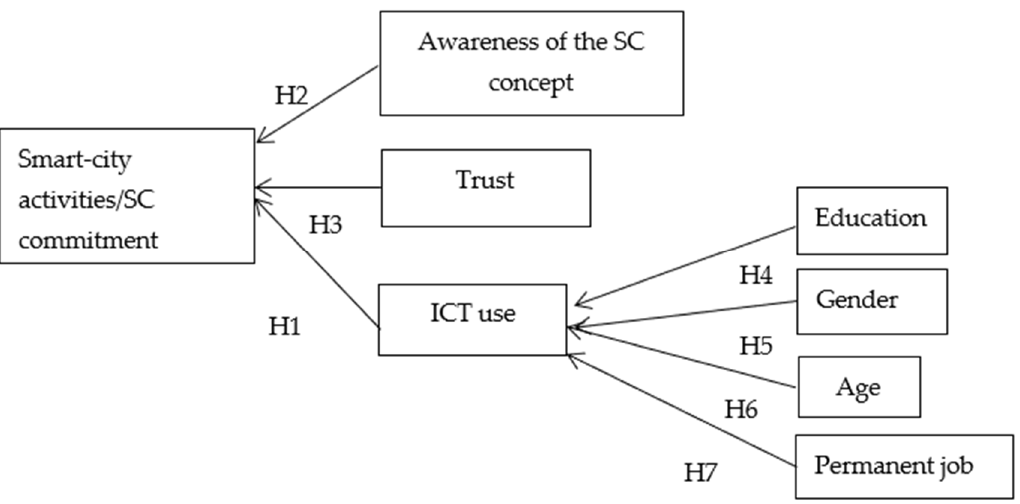
Figure 1. The model to be estimated Source: Own elaboration.